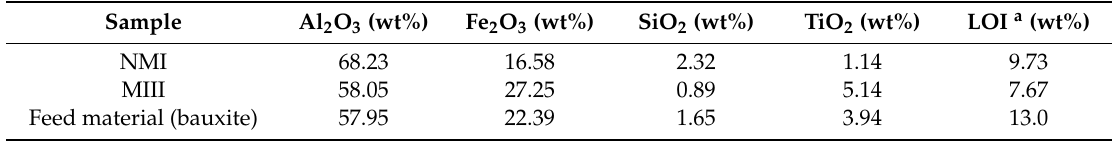
Table 4. Average chemical composition of the non-magnetic product NMI and the magnetic product MIII obtained after reduction roasting followed by magnetic separation in comparison with the feed